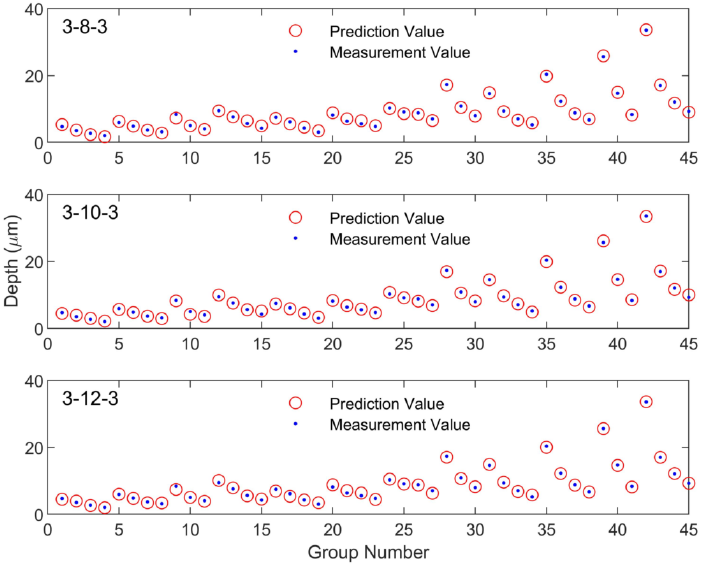
Figure 11. Comparison between the measurement and prediction values of D obtained by three types of network